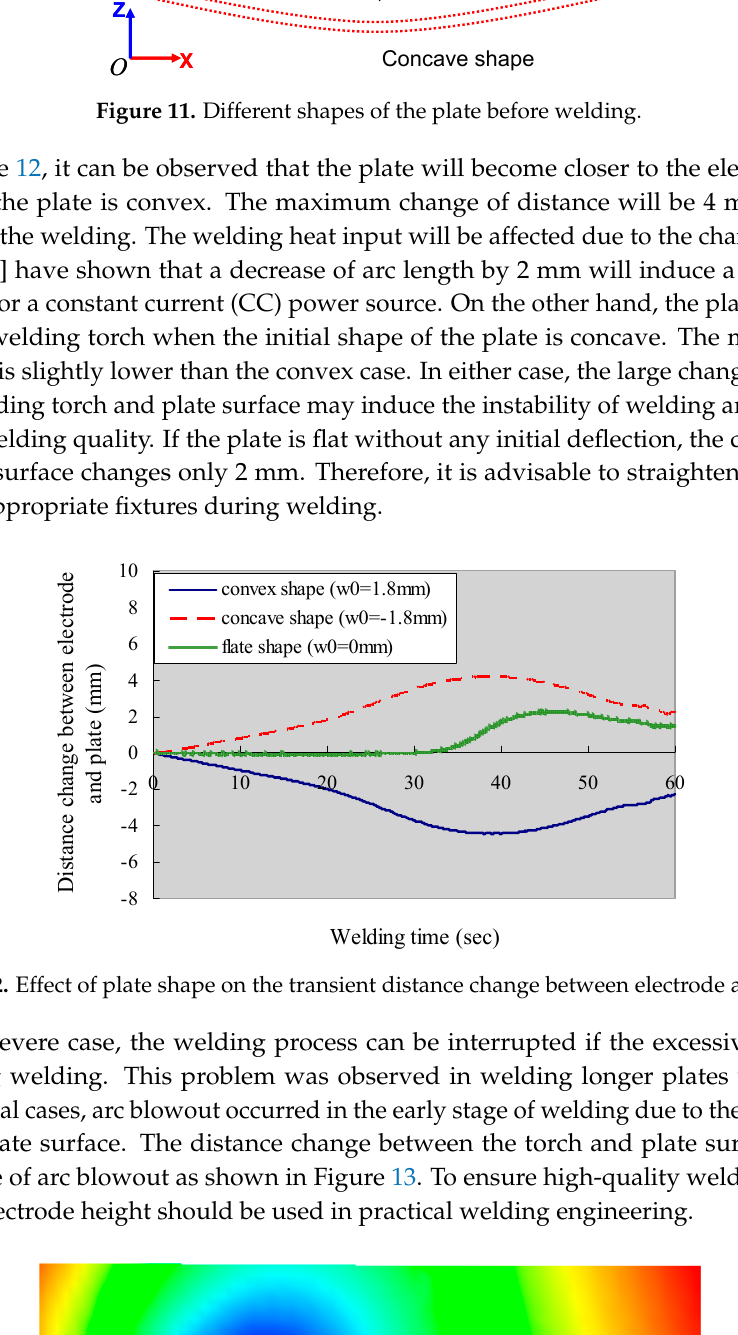
Figure 12. Effect of plate shape on the transient distance change between electrode and plate.